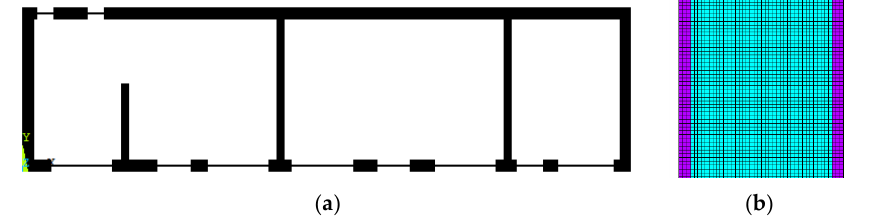
Figure 4. ( a ) Finite element model of the building (plan view) and ( b ) finite element mesh of the internal partition wall.